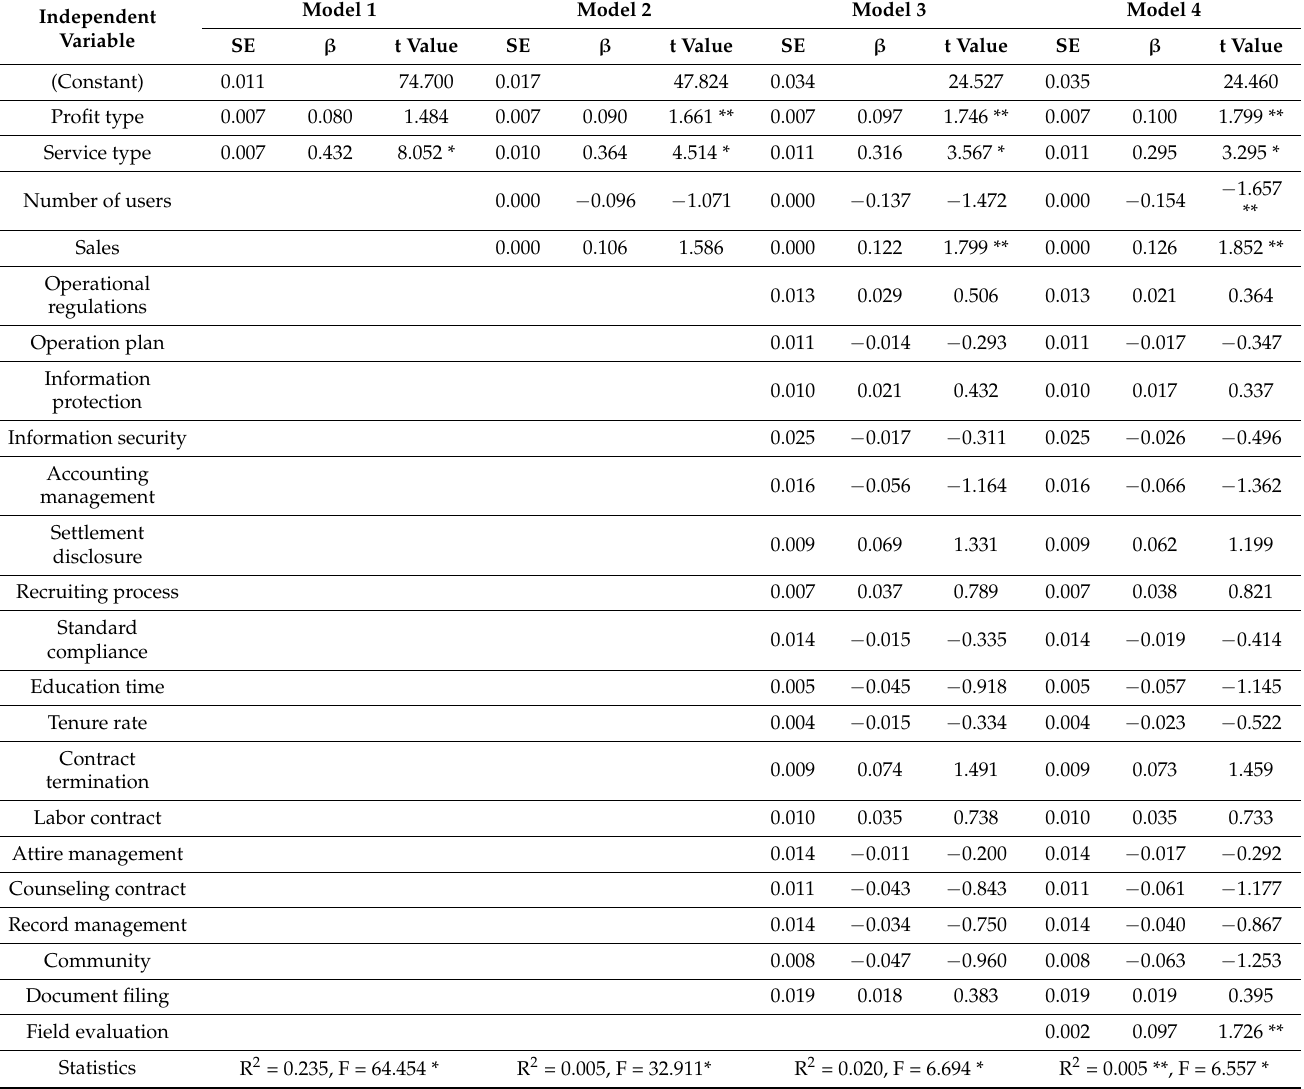
Table 5. Regression analysis for 2016. ( n =